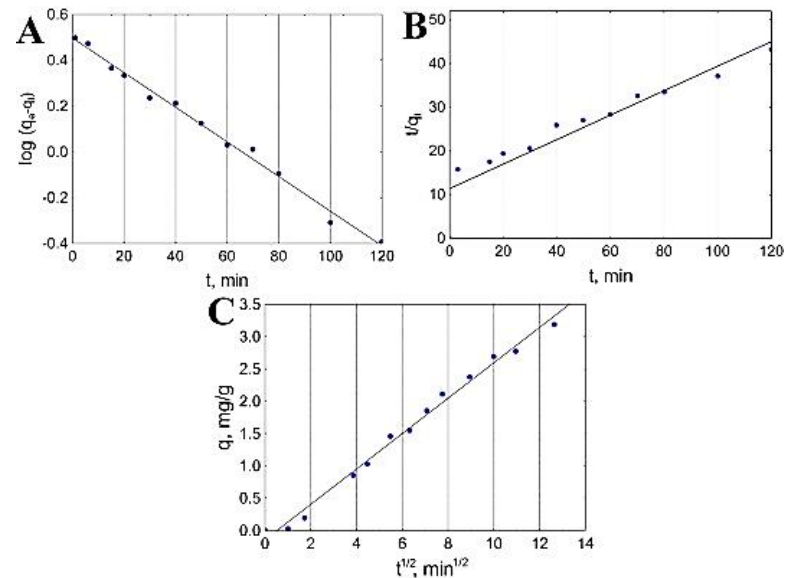
Figure 6. Adsorption kinetic modeling of As into zirconium-modified activated carbon: ( A ) pseudo- first-order, ( B ) pseudo-second-order and ( C ) intraparticle diffusion. Reprinted from Velazquez- Jimenez et al. [25] Copyright 2021 Elsevier.